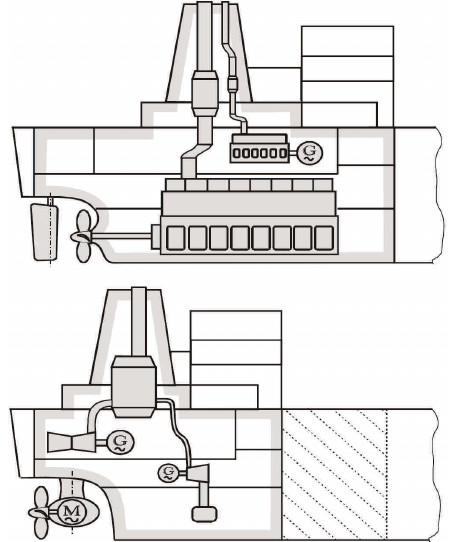
Fig. 2. Comparison of the drive system of the turbine generators of energy in the planned LNG tanker to the traditional direct drive of low-speed compression ignition engine [1]